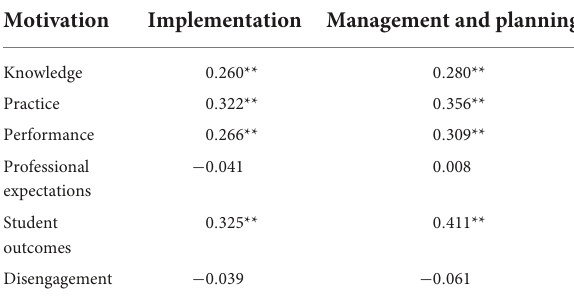
TABLE 8 Pearson’s correlations between confidence and motivation